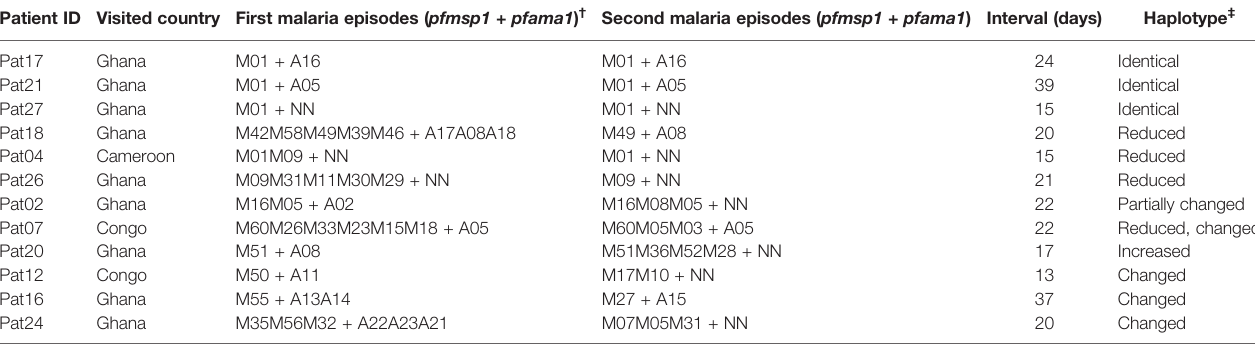
TABLE 2 | Comparisons of pfmsp1 and pfama1 combined haplotypes between fi rst malaria episode and recurrent malaria.